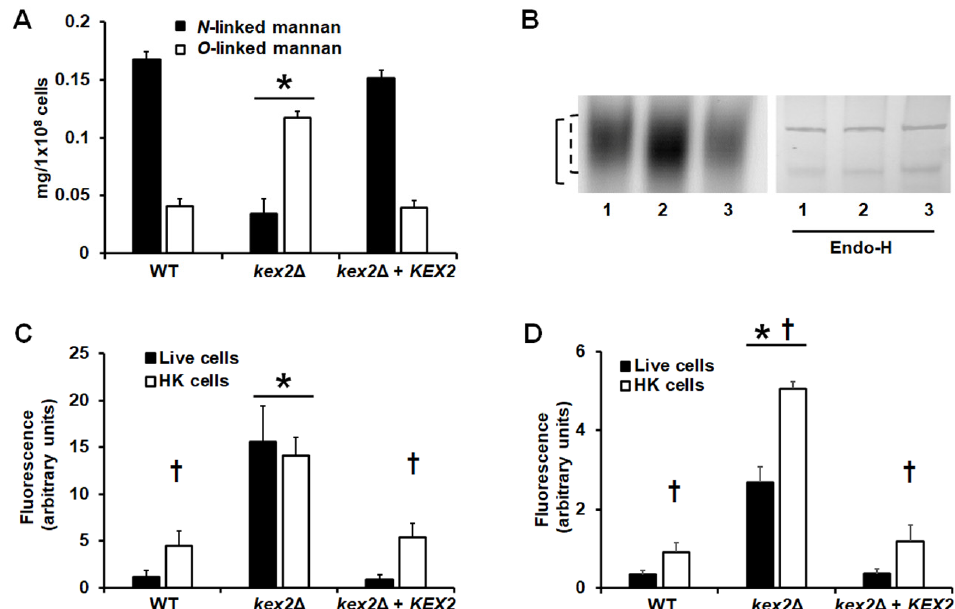
Figure 2. Analysis of cell wall components in the of Candida albicans kex2 Δ null mutant and control strains. ( A ) , cells were deglycosylated by incubating with endoglycosidase H (endo-H) or sodium hydroxide, to remove N -linked mannans or O -linked mannans, respectively, the hydrolyzed oligosaccharides were quantified as described in Materials and Methods. ( B ), Zymogram to reveal Hex1 activity. The dashed line indicates the electrophoretic mobility of the enzyme from both WT and reintegrant control strain, while on the continuous line is the mobility of the protein isolated from the kex2 Δ null mutant. Endo-H refers to samples treated with endoglycosidase H. The height of both gels has been modified to make them shorter. ( C ), Cell wall chitin staining. Live or heat-killed (HK) yeast cells were labeled with fluorescein isothiocyanate-wheat germ agglutinin conjugate that binds chitin, as described in Materials and Methods, inspected under fluorescence microscopy, and the fluorescence associated to 300 individual cells recorded. ( D ), Cell wall β -1,3-glucan staining. Similar to panel ( C ), but cells were stained with IgG Fc-Dectin-1 chimera that binds β -1,3-glucan. Data are means ± SD of three independent experiments performed in duplicates. Strains used are NGY152 (WT, lane 1), HMY209 ( kex2 Δ , lane 2), and HMY210 ( kex2 Δ + KEX2 , lane 3). * P < 0.05, when compared with either the WT or reintegrant control cells. † P < 0.05, when compared with live cells.